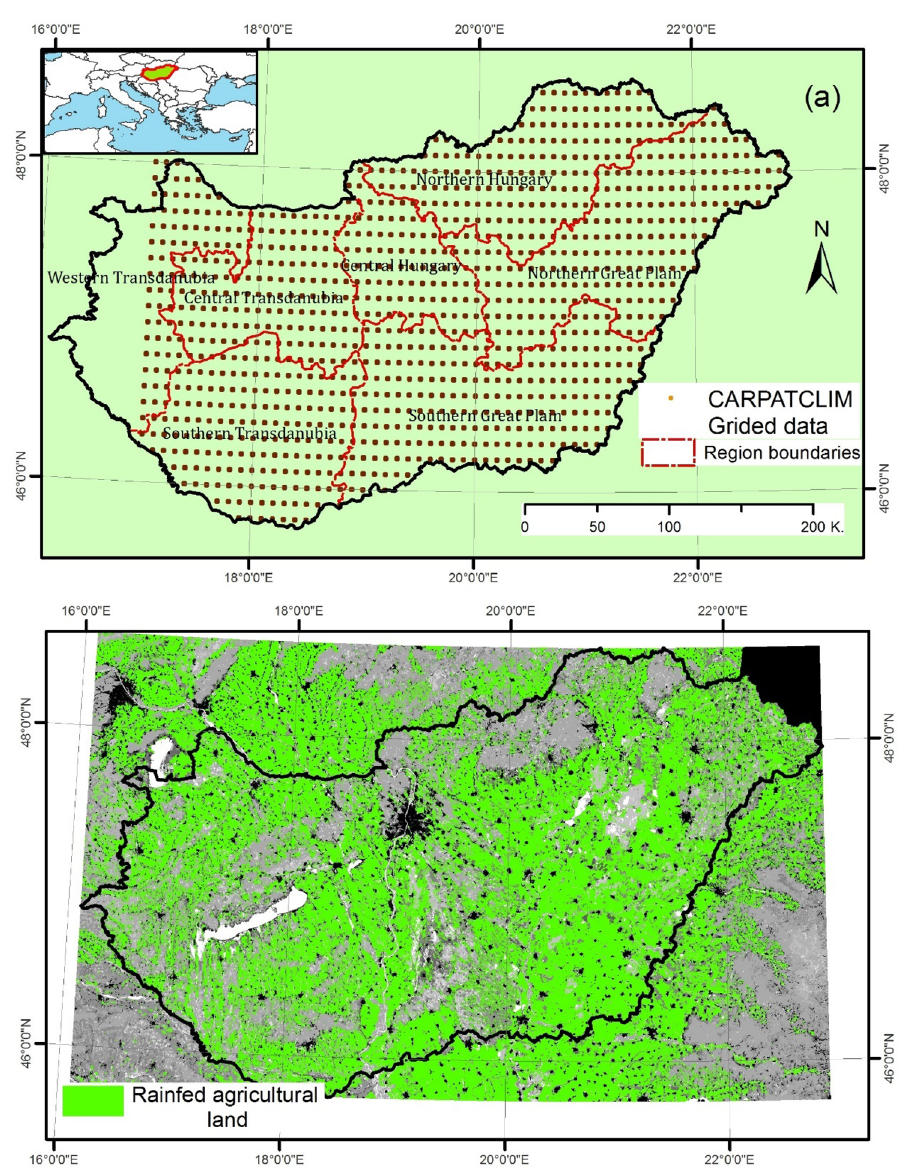
Figure 2. Study area (Hungary): ( a ) Distribution of gridded points across Hungary, ( b ) rainfed agricultural land (CORINE land cover data: https:// land. coper nicus. eu/ pan- europ ean/ corine- land- cover), (maps were generated using ArcGIS 10.5 (https:// www. esri. com/ en- us/ about/ about- esri/ overv